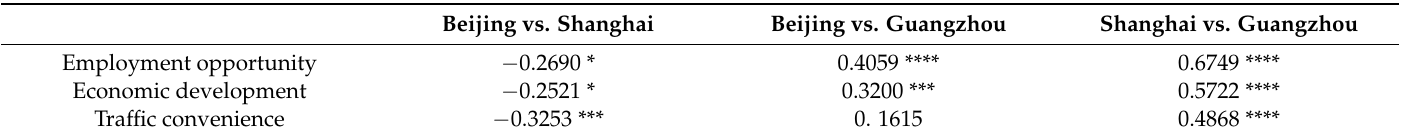
Table 10. ANOVA analysis of perceived cost among Beijing, Shanghai, and